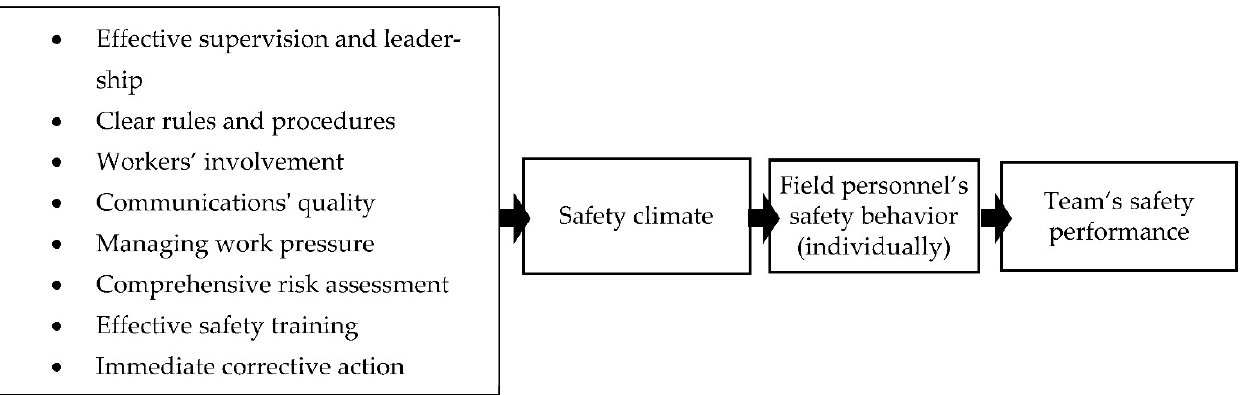
Figure 1. The link between safety measures and the team’s safety performance.